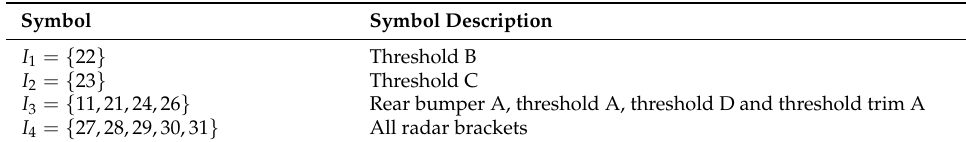
Table 3. Classification of the parts according to